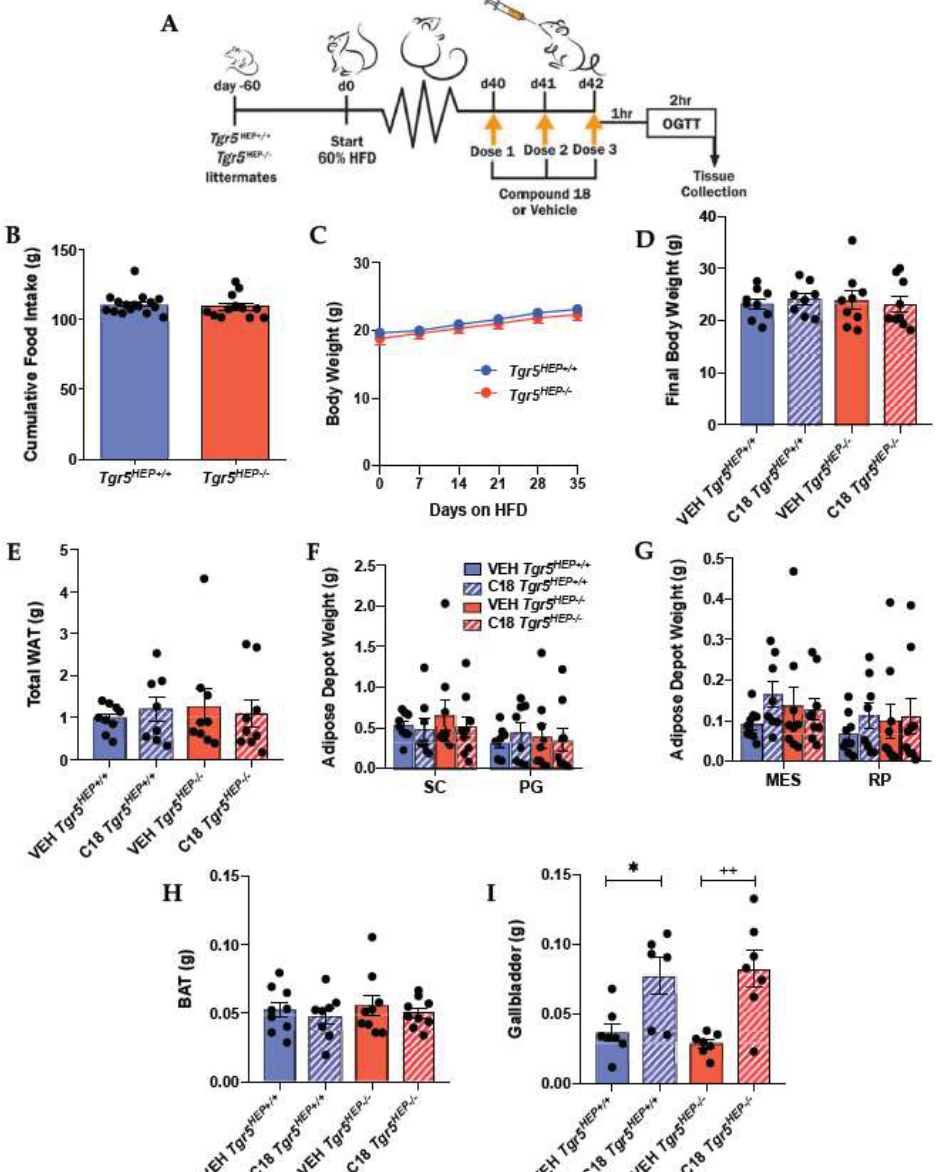
Figure 2. Hepatocyte TGR5 does not contribute to regulation of food intake, body weight, or adiposity. ( A ) Study design. ( B ) Cumulative food intake and ( C ) body weight over 7 weeks of high fat diet (HFD) feeding in Tgr5 HEP +/+ and Tgr5 HEP − / − mice. n = 12–16. ( D ) Body weight at the time of euthanasia; ( E ) total white adipose tissue (WAT) weight; ( F ) subcutaneous (SC) and perigonadal (PG); ( G ) mesenteric (MES) and retroperitoneal (RP) adipose tissue weights; ( H ) brown adipose tissue (BAT) weights; and ( I ) gallbladder weight in Tgr5 HEP +/+ and Tgr5 HEP − / − mice treated with Compound 18 (C18) or vehicle (VEH). n = 6–9. * p < 0.05 compared with VEH Tgr5 HEP +/+ ; ++ p < 0.01 compared with VEH Tgr5 HEP − / − by two-factor